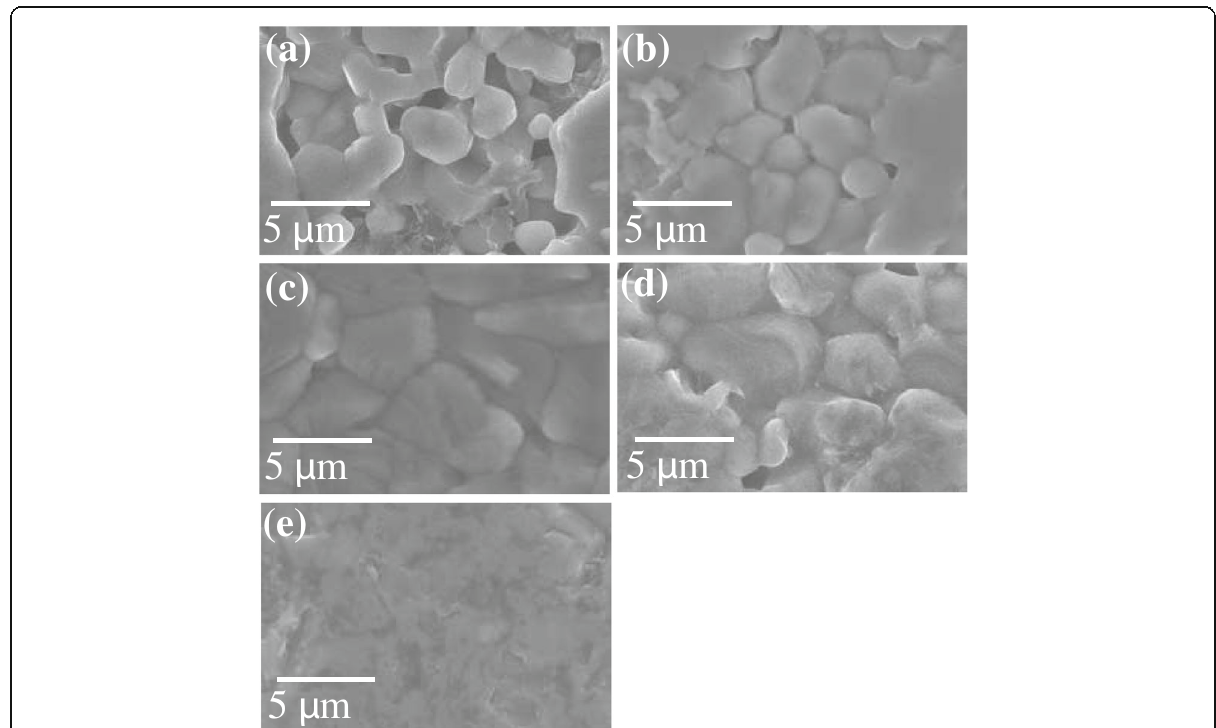
Fig. 7 FESEM images of SiC pellets sintered with nanosized Si-SiC composite nanoparticles and activated carbon by SPS process (details of a , b , c , d , and e are given in Table